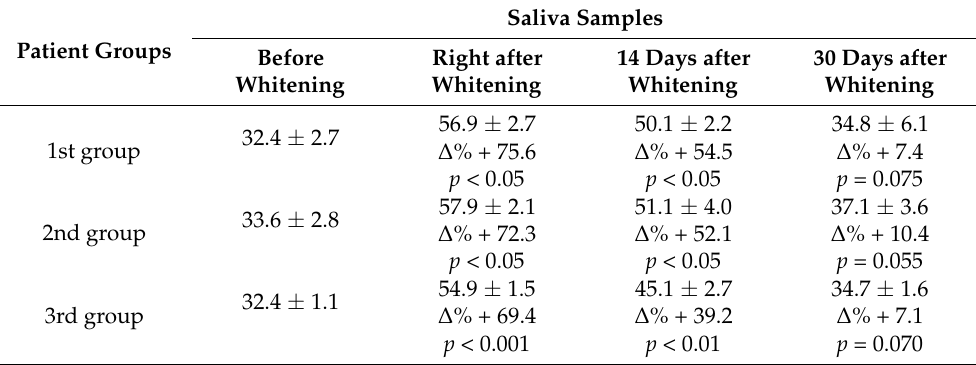
Table 3. Activity of superoxide dismutase (SOD) in the oral fluid before and at different times after tooth whitening (conventional units). Saliva Samples Patient Groups Before Right after Whitening